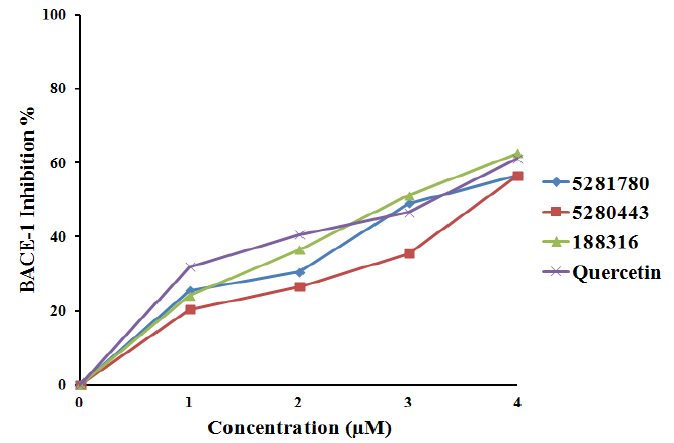
Figure 8. BACE-1 inhibition percentage and inhibitor concentration plot.